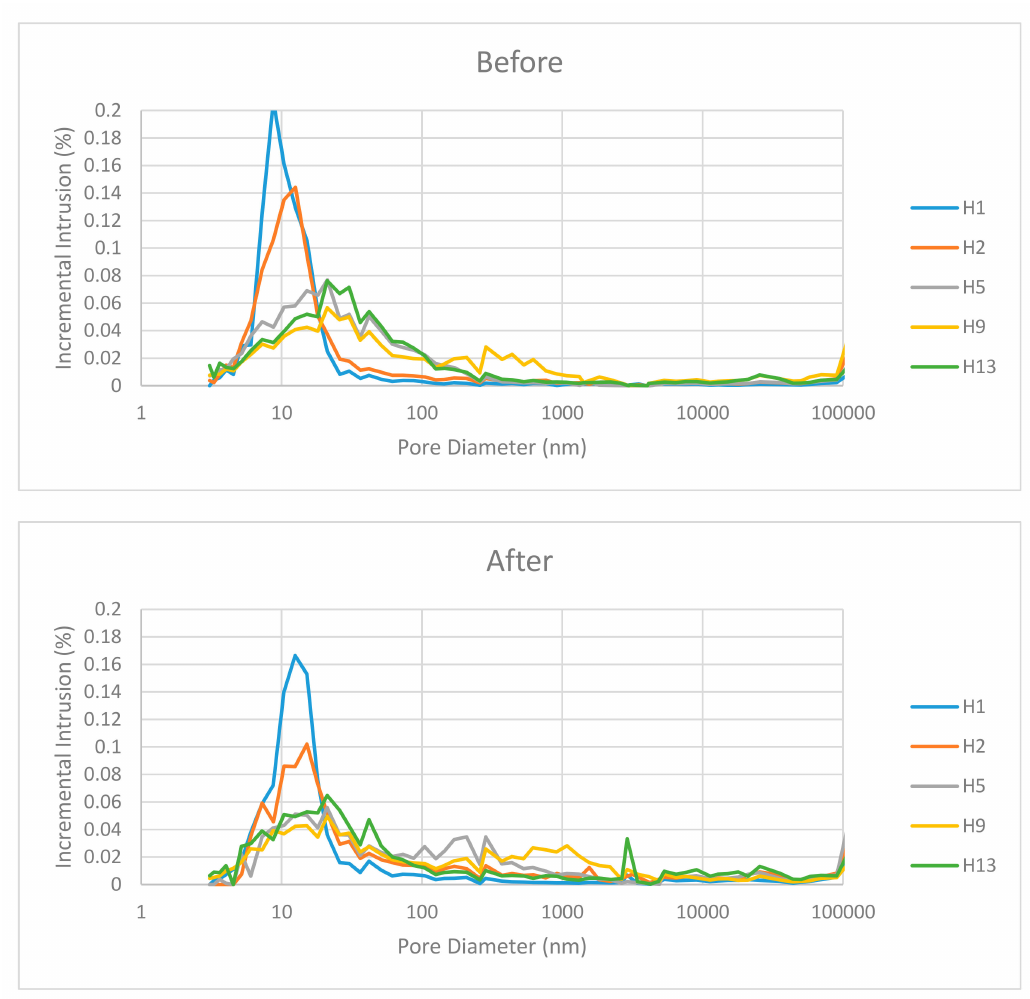
Figure 10. Incremental Intrusion vs Pore